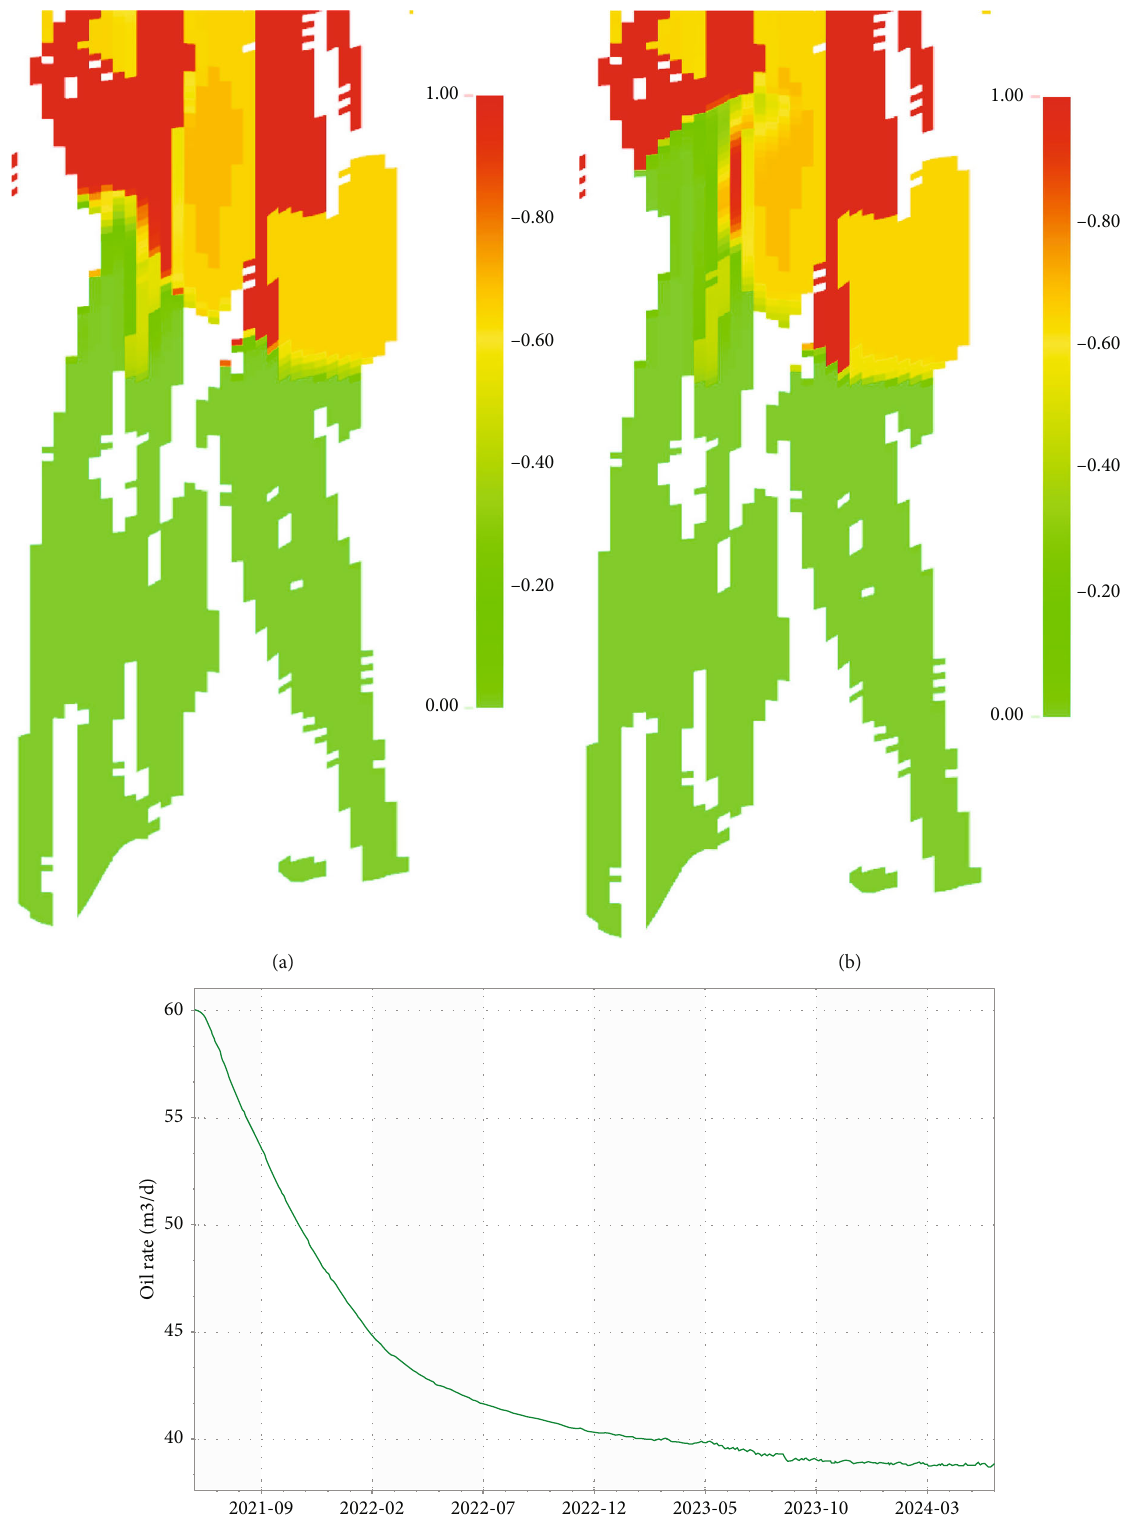
Figure 16: Sidetracking e ff ect on the residual oil near the L19